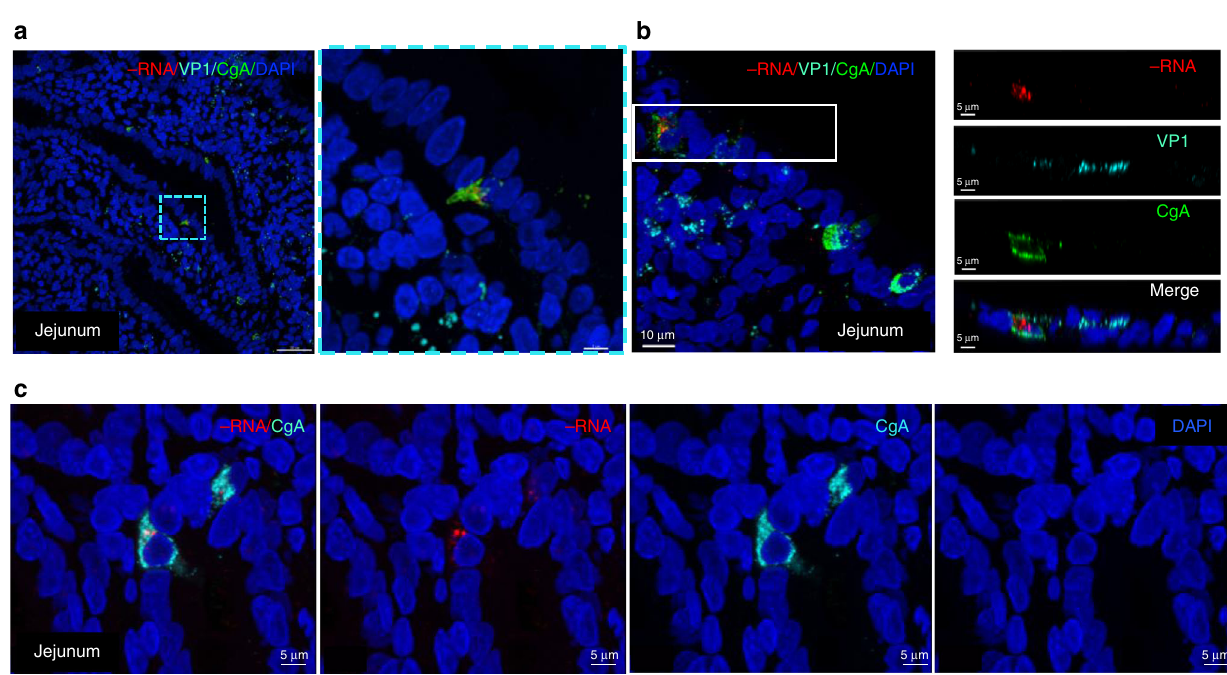
Fig. 4 Presence of norovirus negative-sense RNA in chromogranin A-positive cells. Chromogranin A (CgA) is a protein released by neuroendocrine cells, and it has been used as a general marker for intestinal enteroendocrine cells (EECs). a Confocal imaging of the GT-1 jejunal biopsy showing CgA (green)- positive cells with and without the presence of norovirus negative-strand RNA (red) and VP1 (cyan) in the intestinal epithelium. Inset shows magni fi ed view of the norovirus-positive EEC. b Confocal imaging and side views of an individual cell staining with CgA (green), negative-sense RNA (red) and VP1 (cyan). c GT-1 jejunal biopsy with two proximal epithelial cells bearing the presence of both CgA and negative-sense RNA. Merged and separate images of norovirus negative strand (red), CgA (cyan), and DAPI (blue) nuclei staining are